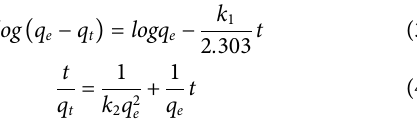
Frontiers in Environmental Chemistry |